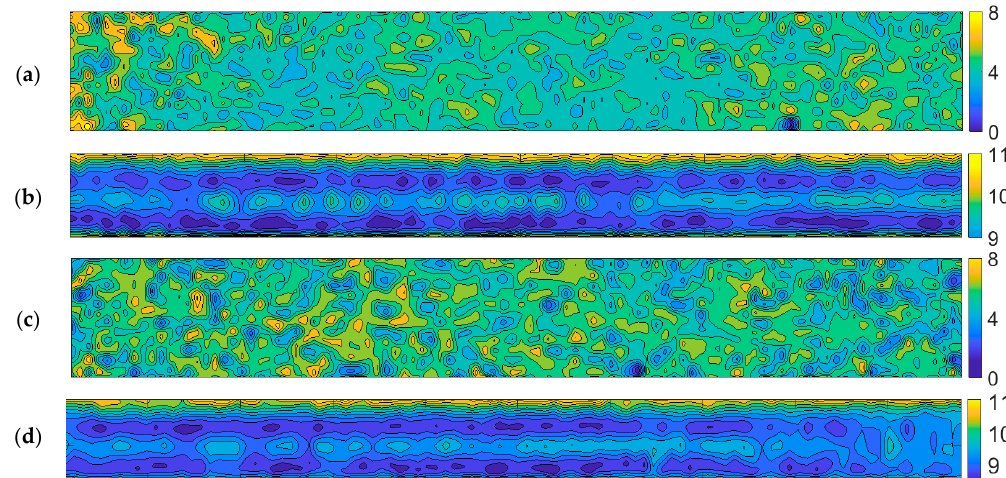
Figure 9. Maps of web ( a , c ) and flange ( b , d ) thickness distributions